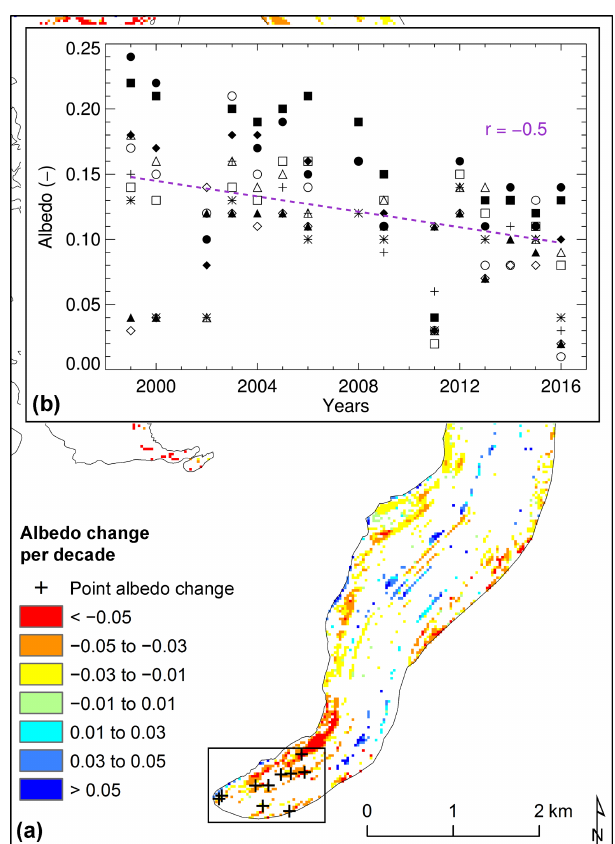
Figure 7. (a) Close-up of bare-ice albedo trends per decade signifi- cant at the 95% confidence level or higher for the tongue of Aletsch, and (b) time series of bare-ice albedo between 1999 and 2016 for ten randomly selected points on the terminus (crosses in a ) includ- ing a linear fit (dashed purple, r = − 0 .